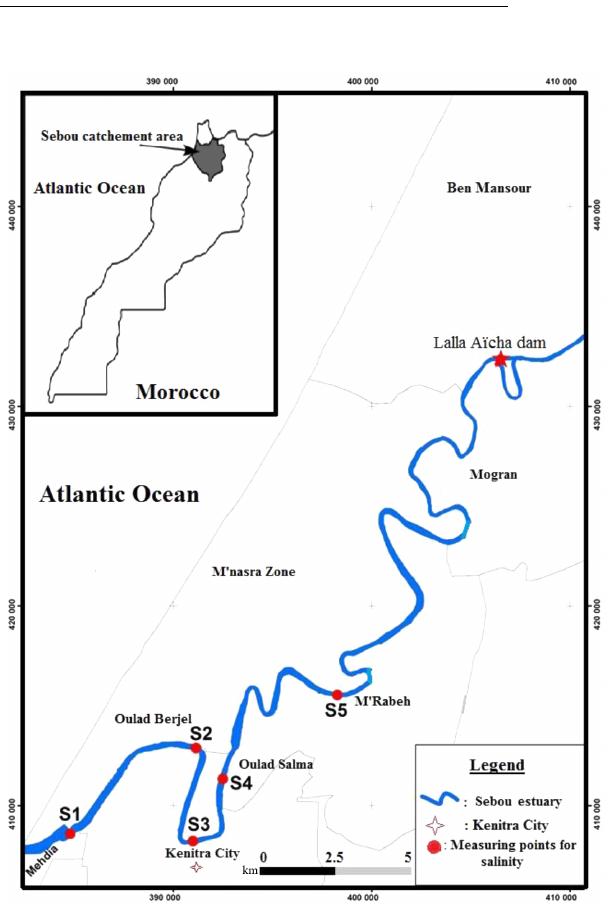
Figure 3. Study area and measurements sites in the Sebou river es-